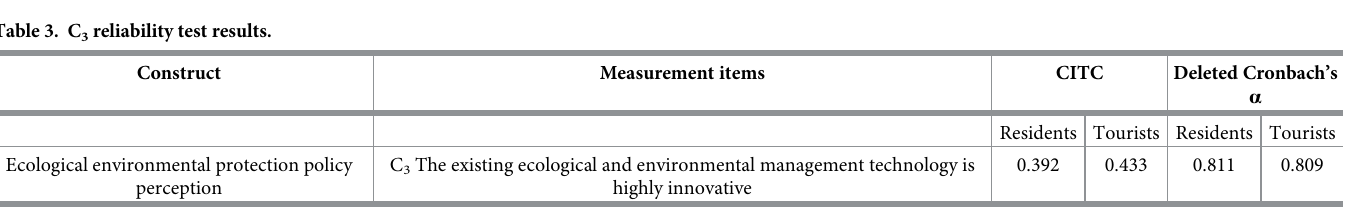
Table 3. C 3 reliability test